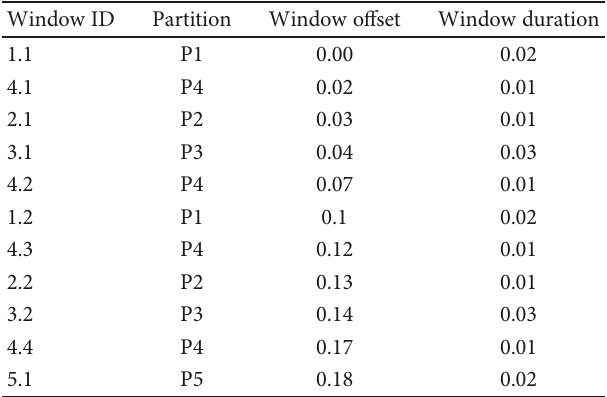
Table 12: Partition con fi guration schedule rules. Window ID